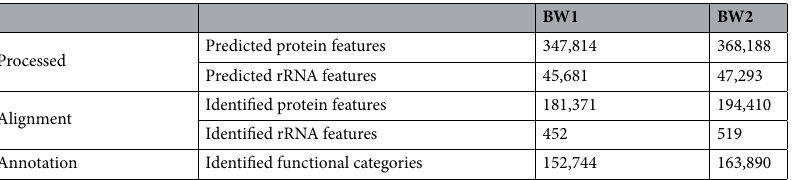
Table 2. MG-RAST resume of the two replicates of As Burgas water metagenome (BW1 and BW2 samples MG-RAST Ids mgm4709017.3 and mgm4709018.3